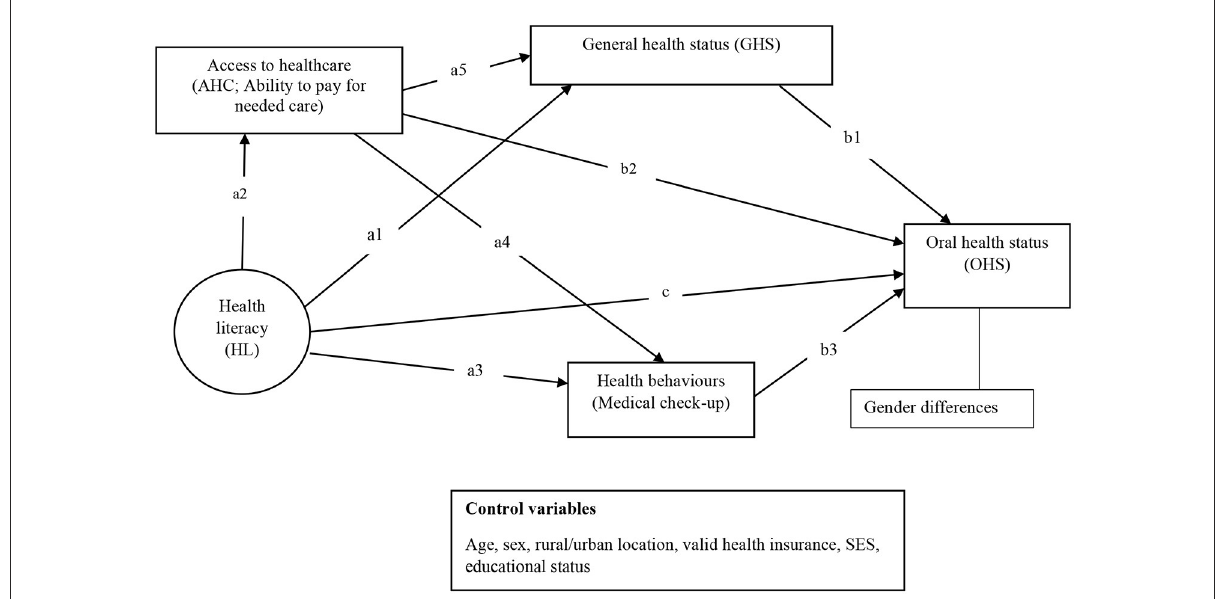
FIGURE1 A heuristic conceptual and analytical framework underpinned by the causal pathway between health literacy and health outcomes model (11).